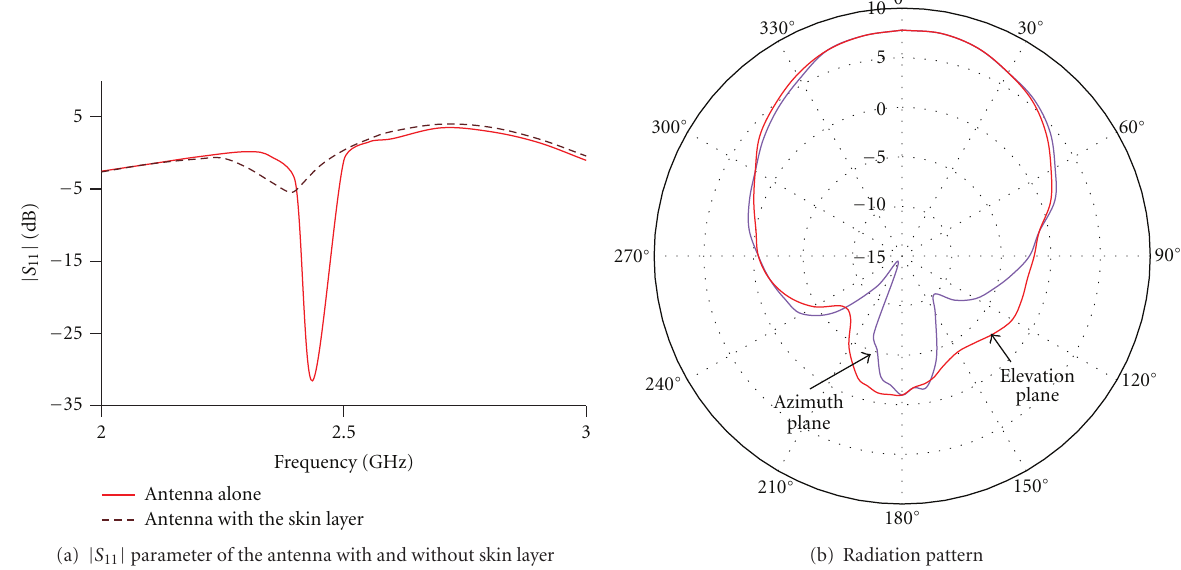
Figure 2: Simulation results of the initial flexible microstrip antenna design before modifying for optimized skin contact operation.